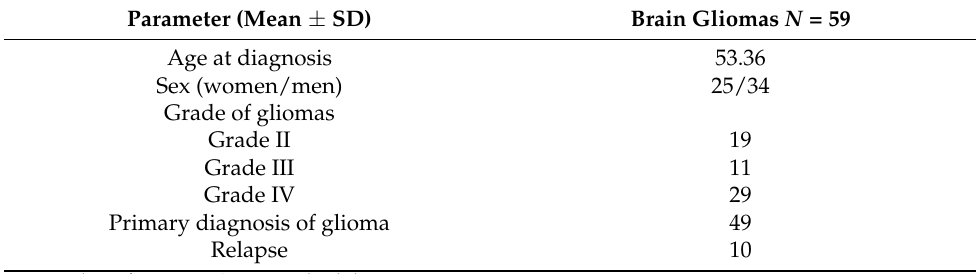
Table 1. Characteristics of the study group of glioma